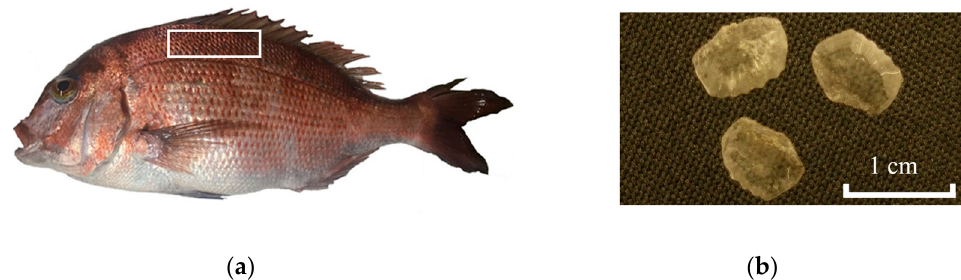
Figure 1. Body of red sea bream ( a ) and “key scale” from fish body white border ( b ).